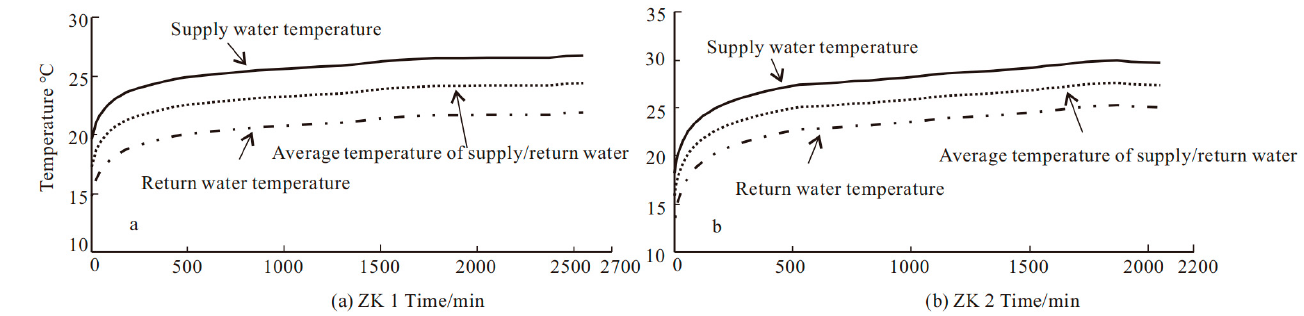
Figure 2. Supply/return water and its average temperature change curves of the testing well ZK1 ( a ) and ZK2 ( b ).